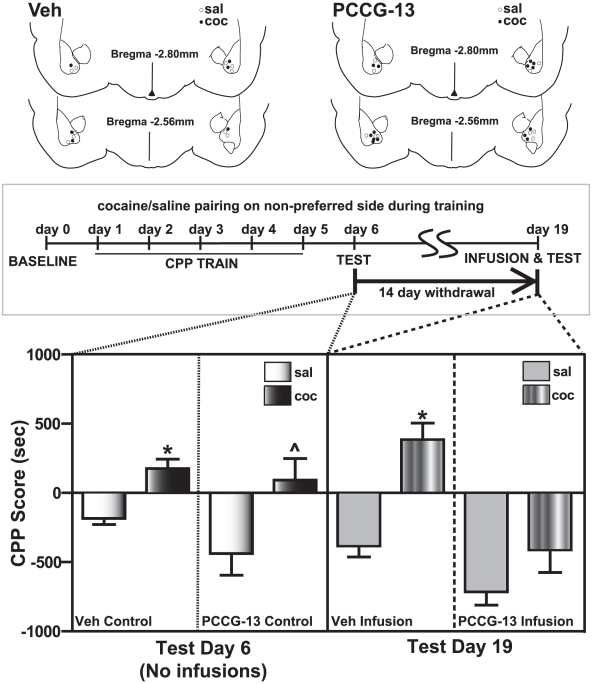
Expression of cocaine CPP was blocked by bilateral infusions of the PLD-linked mGluR antagonist into the amygdala of cocaine CPP group 14 days after the last CPP training.Infusions of the vehicle into the cocaine CPP animals (striped bars, 383.5±121.0, n = 3, Veh infusion panel) on test day 19 do not diminish cocaine CPP (black bars, 176.1±56.3, n = 3, Veh control panel) measured on test day 6. No significant changes were observed in the behavioral response of the saline-treated group between day 6 (white bars, −170.2±36.2, n = 5, Veh control panel) and day 19 (grey bars, −369.2±71.3, n = 5, Veh infusion panel), suggesting that the vehicle infusions alone had no effect. PCCG-13 infusion 15 minutes prior to CPP testing results in a marked loss of preference for the drug-associated side (black bars, cocaine day 6: 92.4±145.9, striped bars, cocaine day 19: −397.1±155.6, *p<0.05, n = 7, PCCG-13 control and PCCG-13 infusion panels respectively) in the cocaine CPP animals, while no significant change in the behavioral response is observed in saline-treated group (white bars, saline day 6: −423.5±149.7, grey bars, saline day 19: −700.8±143.2, ns, n = 5, PCCG-13 control and PCCG-13 infusion panels respectively). *p<0.05 compared to the corresponding vehicle control (saline) and by ∧p<0.05 compared to the corresponding vehicle control (PCCG-13). Cannulae placement for the animals is depicted (above the graph) for both the vehicle (Veh) and drug (PCCG-13). These sites were mapped to BLA on rat brain atlas [127] templates. A schematic representation of the experimental protocol utilized for CPP training along with the two days of CPP testing is illustrated above the corresponding data in the graph below.